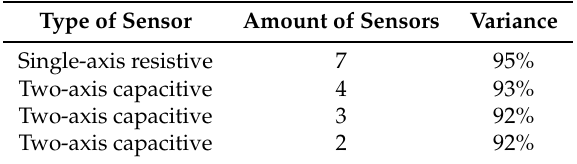
Figure 1. Different locations for the variance estimation. ( a ) Four soft angular displacement sensors (sADS) were placed in the recommended intermediate poses. ( b ) The frontal sADS was eliminated due to its low representation in the variance; it also generated obstructions and poor measurements in the horizontal gestures. The three previous poses were preserved. ( c ) Placement of two sADS, one in the centre of the two sADS of the top three sensor array, and the other in the rear, generating an angle of 90 ◦ between the two planes with respect to the first. Table 1. Result of the estimated variance for different sADS